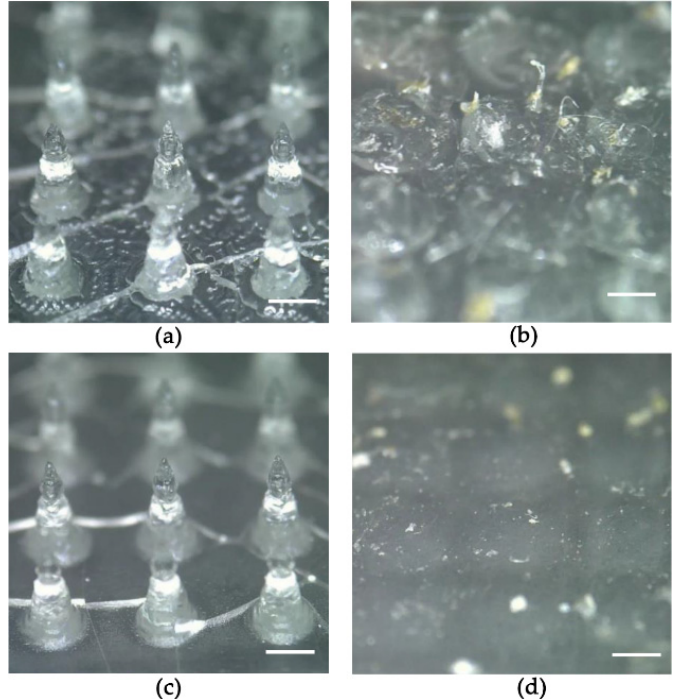
Figure 4. Dissolution of donepezil-loaded DMNs after application to rats. Images of microneedles ( a ) before and ( b ) after 1 h application, and ( c ) before and ( d ) after 1 week application. The scale bars represent 500 µ